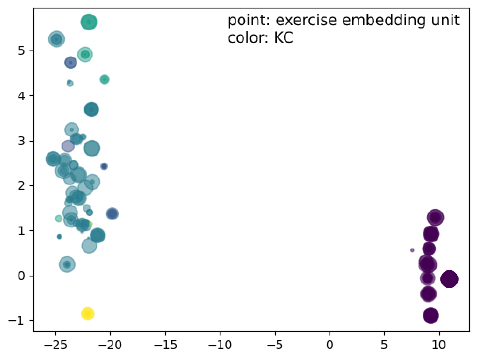
Figure 8. t-SNE visualizations of exercise embedding